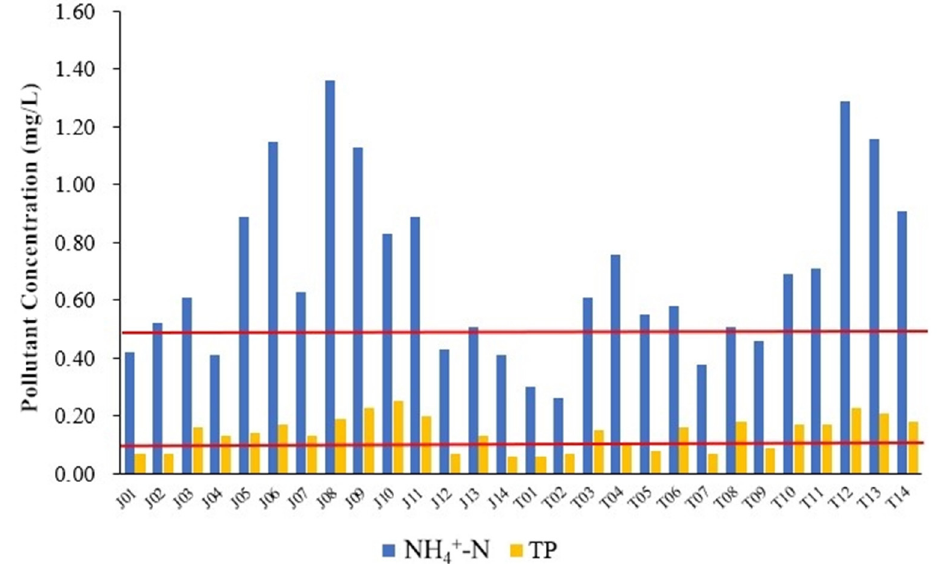
Figure 5. Pollution index concentrations at the 28 monitoring points. The upper and lower red lines indicate the concentration standards of NH 4+ -N (0.5 mg/L) and TP (0.1 mg/L), respectively.